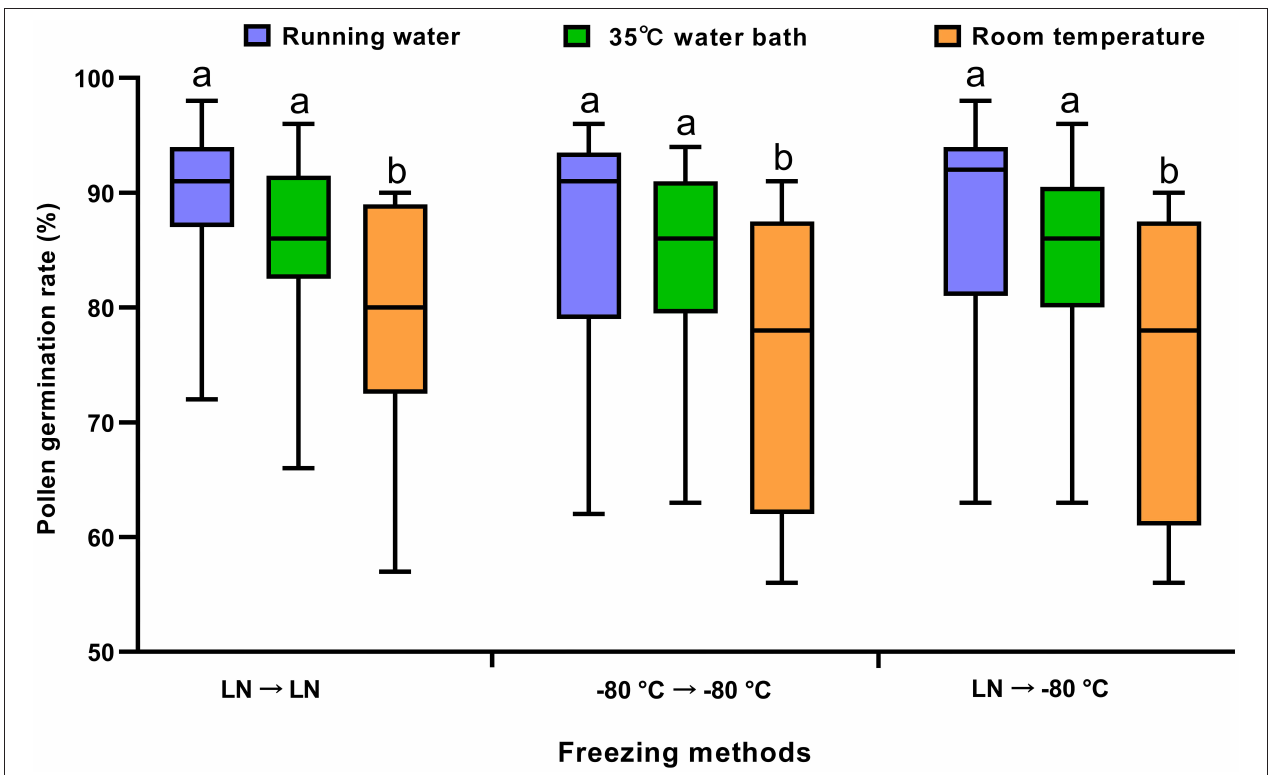
FIGURE 6 | Comparison of germination rates of preserved soybean pollen after different preservation and thawing methods. LN → − 80 ◦ C, frozen in liquid nitrogen for 72h and then stored in a − 80 ◦ C freezer; − 80 ◦ C → − 80 ◦ C, frozen and preserved continuously in a − 80 ◦ C freezer; LN → LN, frozen and preserved in liquid nitrogen. The preserved samples were thawed for 1min by three methods. Means of germination rates of preserved pollen after different preservation and thawing methods were separated by Duncan’s multiple range test at P < 0.05, where the F -test was